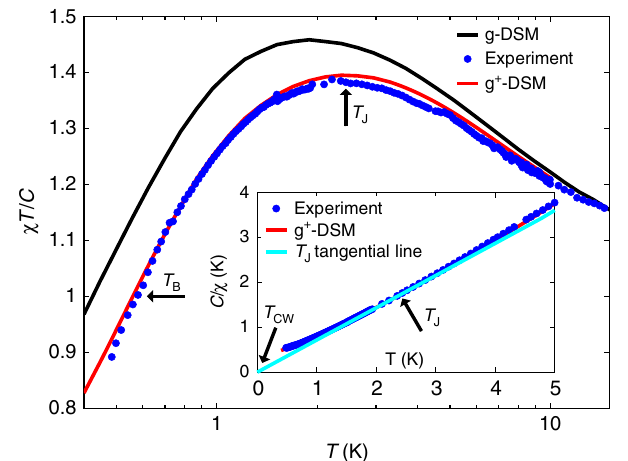
Fig. 1 Magnetic special temperatures in spin ice, Dy 2 Ti 2 O 7 . Experimental susceptibility χ T / C in blue, with arrows indicating the special temperatures T T J and B . The black curve marks the previously determined g tuned parameter set g + – DSM is shown in red. The inset displays C / χ , and the solid line demonstrates that T CW ( T ) = 0 at T = T